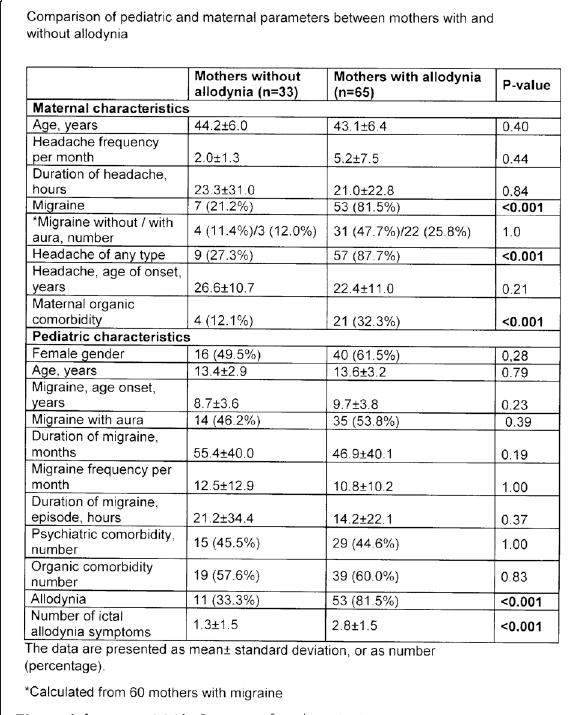
Fig. 1 (abstract 230). See text for